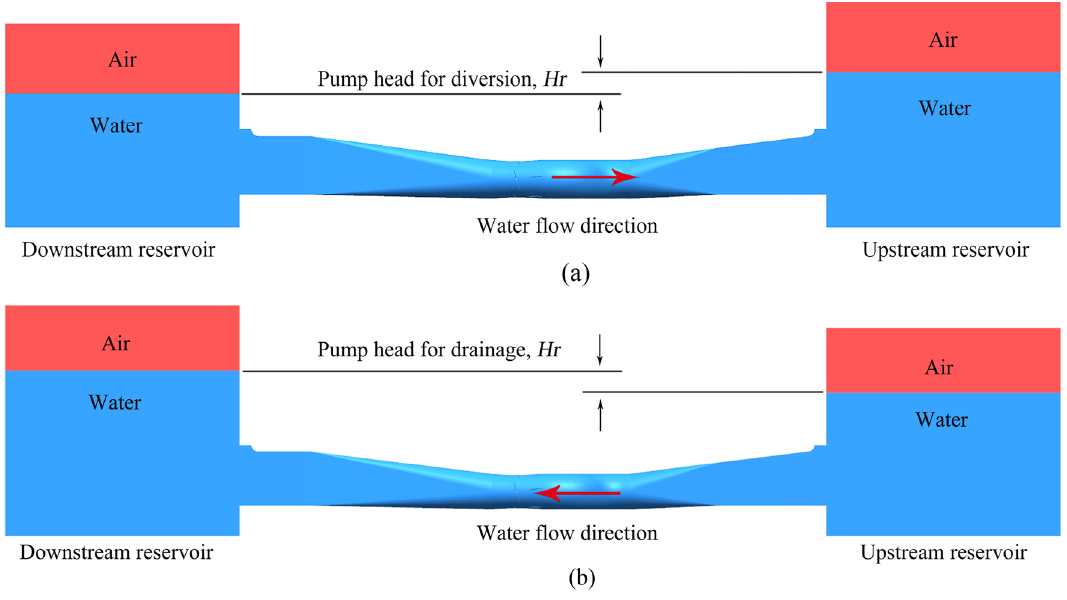
Figure 2. Initial flow field of the calculated domain, ( a ) FRC, ( b )